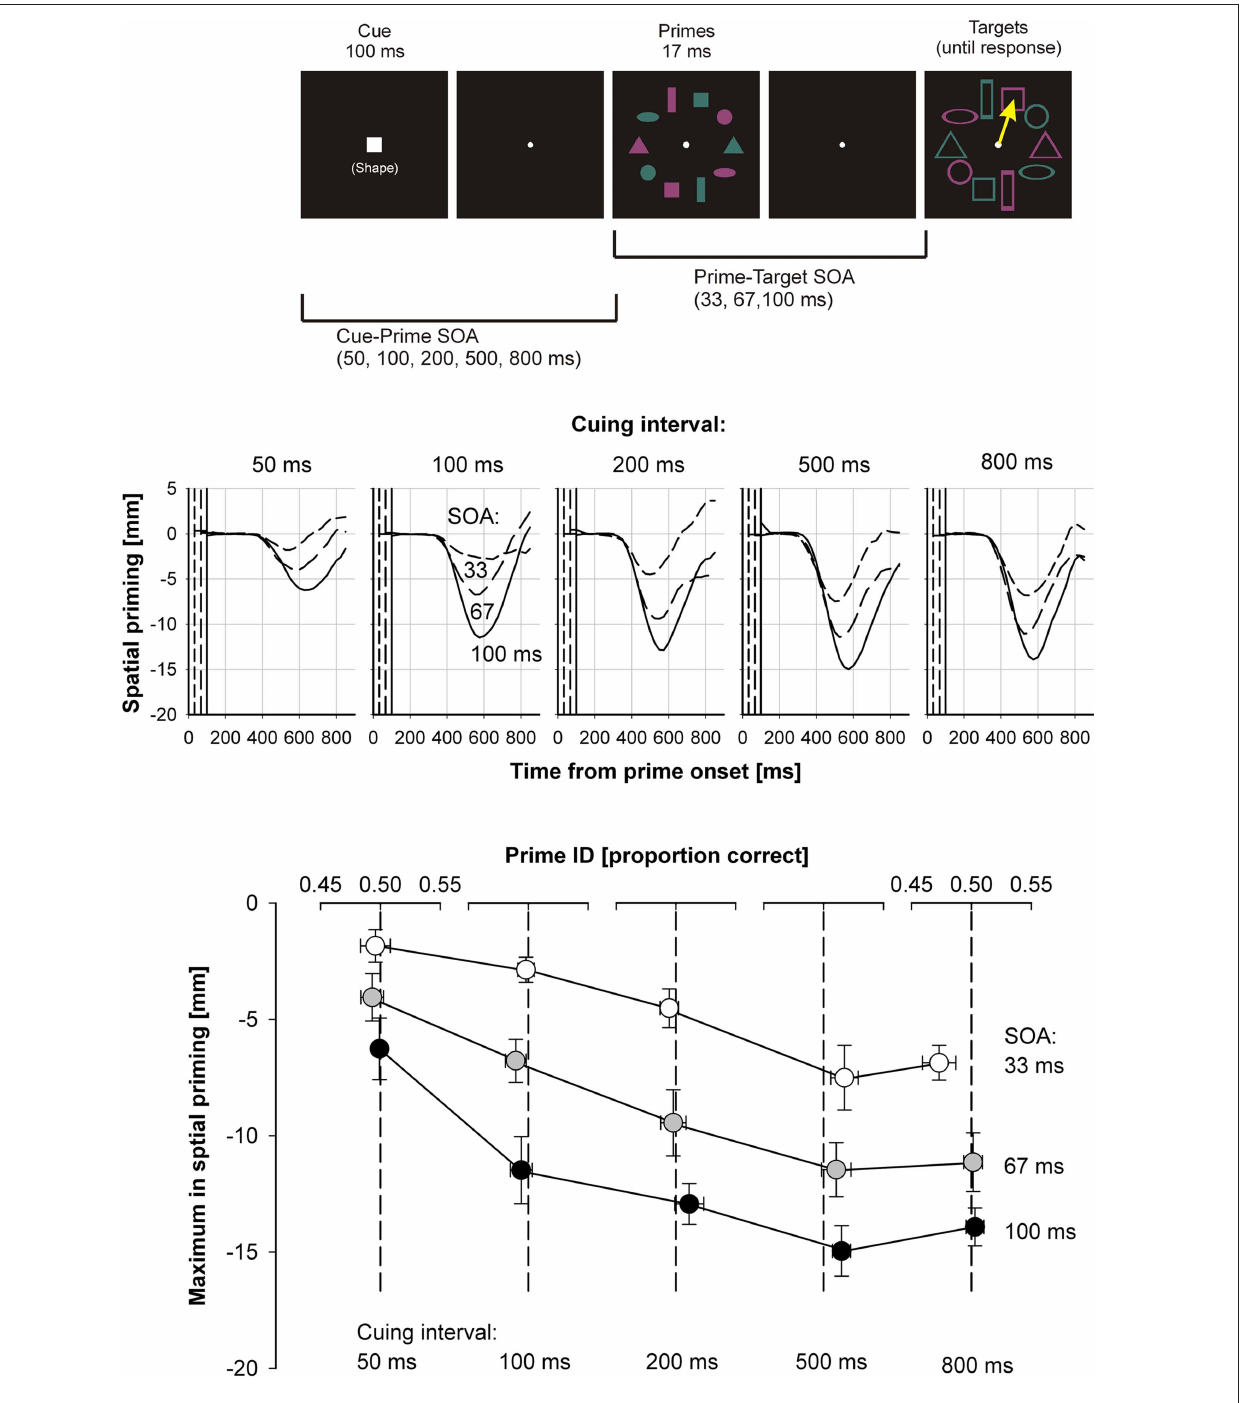
Figure 3 | Paradigm and results from Schmidt and Schmidt (2010; experiment 2). Upper panel: time course of a trial. Participants point from the center of the display to the red one of the two targets indicated by the shape cue (here, a square). Middle panel: spatial priming functions for different cuing